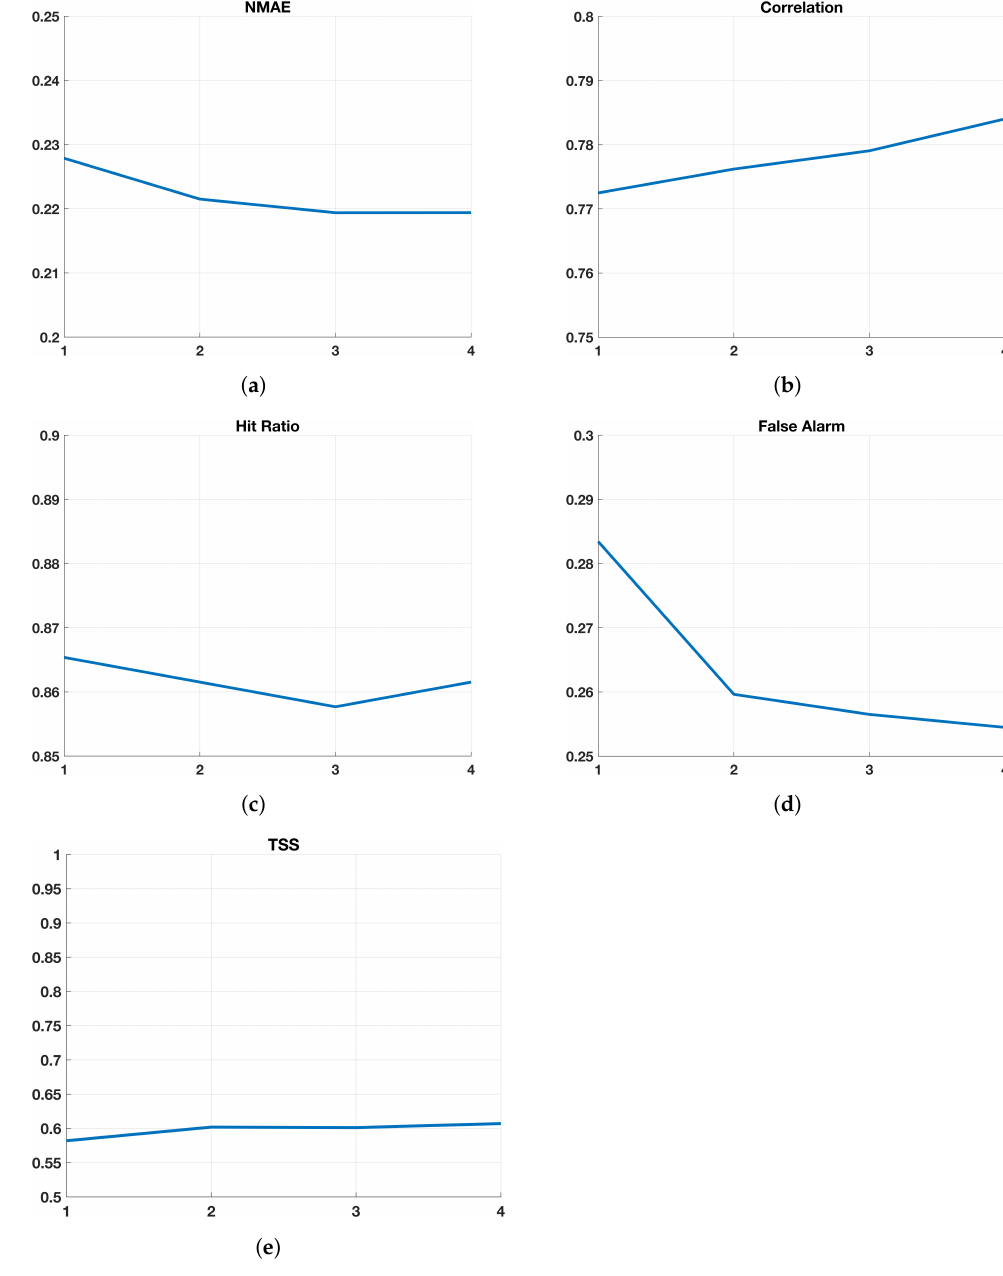
Figure 1. Index values (ordinate axis) of ARX model for ( K = 1) with n a = n l = 1 . . . 4 (abscissa axis). ( a ) Normalized Mean Absolute Error (NMAE); ( b ) Correlation Coefficient; ( c ) Hit Ratio; ( d ) False Alarm; ( e ) True Skill Score